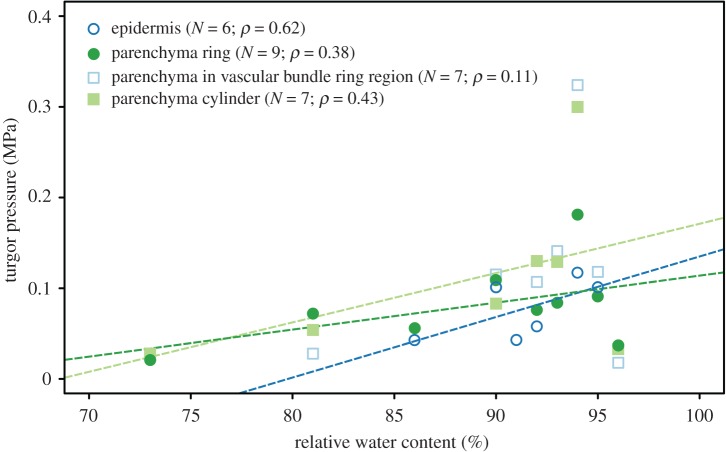
Relationship between turgor pressures and RWCs in different tissues of M. horsfieldii hypocotyls. In the cells of the epidermis (blue open circles), the parenchyma ring (green circles) and the parenchyma cylinder (light-green squares), the turgor pressure correlates positively with the RWC (Spearman's correlation coefficients are given). Only the parenchyma cells in the vascular bundle ring region (light-blue open squares) show no correlation between the RWC and the turgor pressure. The ρ values are given to show a general trend. However, it has to be kept in mind that for a reliable statistical analysis, much larger sample sizes would be necessary. N, sample size; ρ, correlation coefficient.